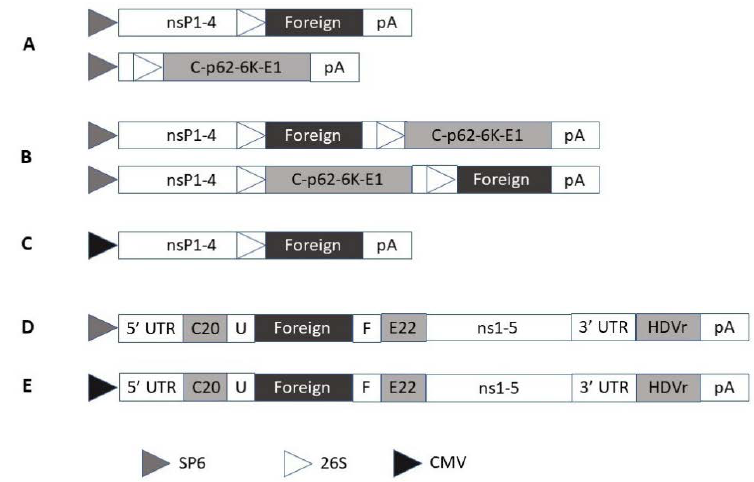
Figure 1. Self-replicating alphavirus and flavivirus vectors. ( A ) Replication-deficient alphavirus system with expression vector (above) and helper vector (below). ( B ) Replication-proficient alphavirus system including two alternative insertion sites. ( C ) DNA/RNA layered Semliki Forest virus (SFV) vector. ( D , E ) KUN vectors with SP6 and CMV promoters, respectively. 26S, subgenomic promoter; C20, first 20 amino acids of KUN C protein; CMV, cytomegalovirus; E22, last 22 amino acids of KUN E protein; F, Foot-and-mouth disease virus 2A autoprotease; HDVr, Hepatitis delta virus ribozyme; pA, polyadenylation signal; SP6, bacteriophage RNA polymerase; T7, phage T7 RNA polymerase promoter; U, mouse ubiquitin sequence; 3′ UTR, 3′ untranslated region; 5′ UTR, 5′ untranslated region.